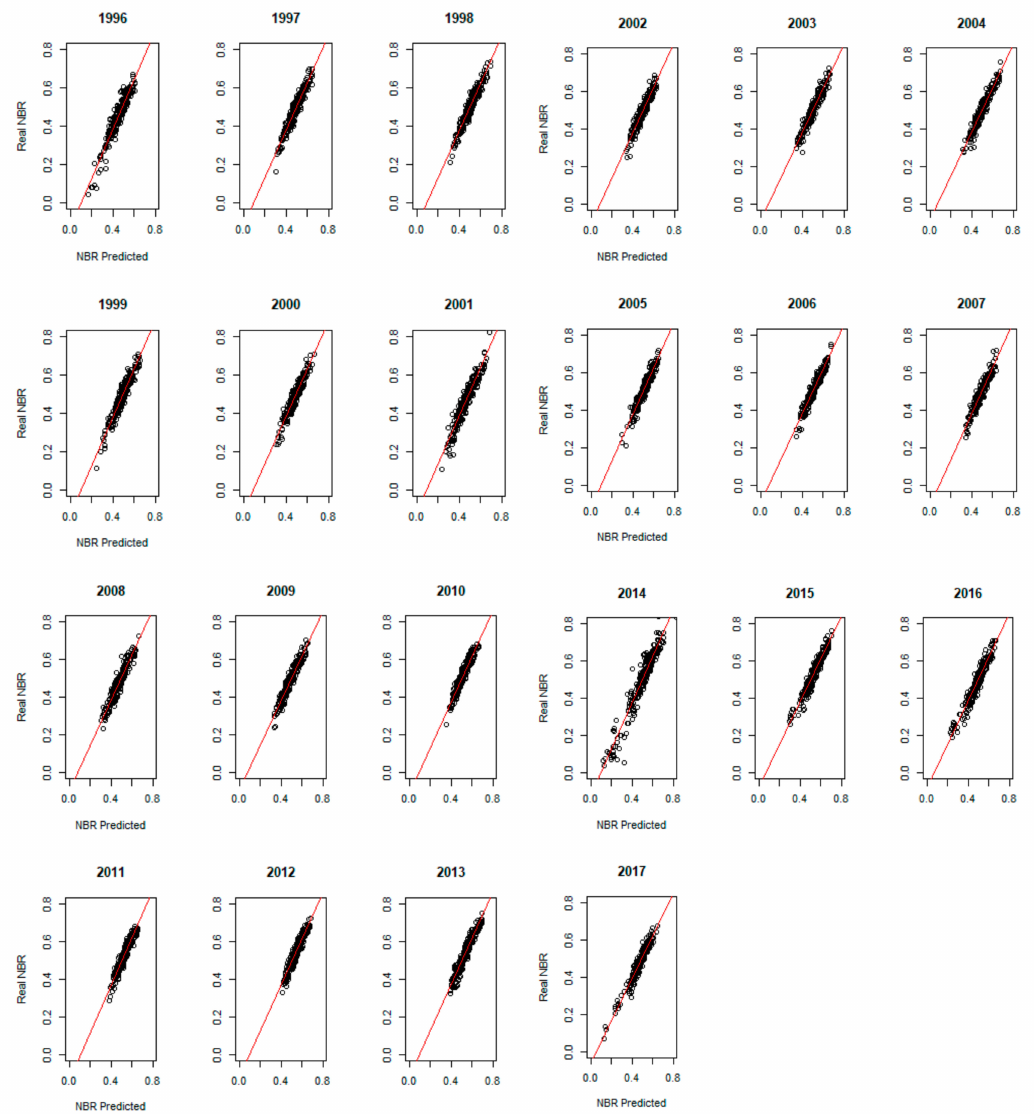
Figure 6. Comparison of the predicted NBR and the real NBR of 255 tested points in the period 1996–2017. The solid line was the regressed line of the sample points with the least square regression method (see also Table S3 for the whole period